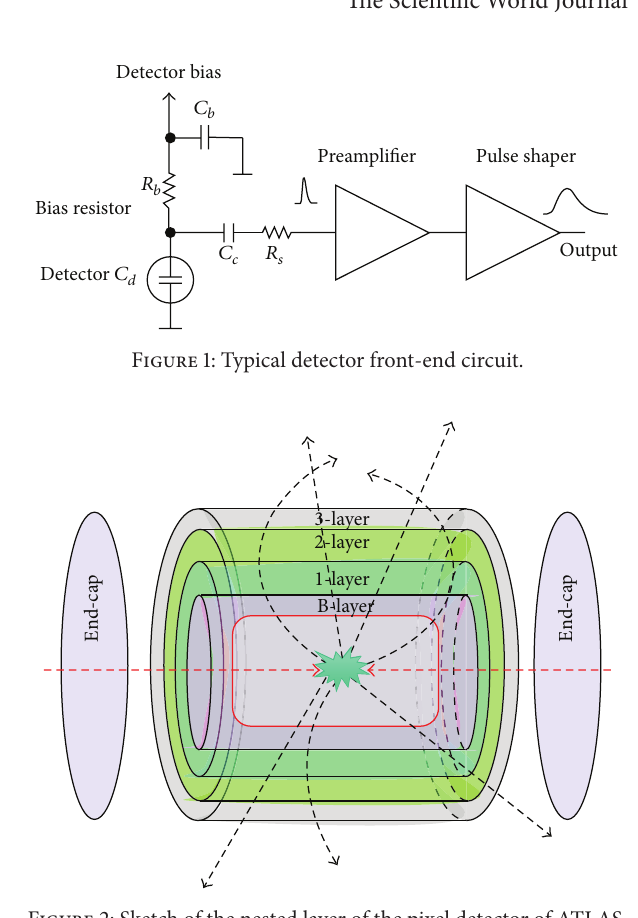
Figure 2: Sketch of the nested layer of the pixel detector of